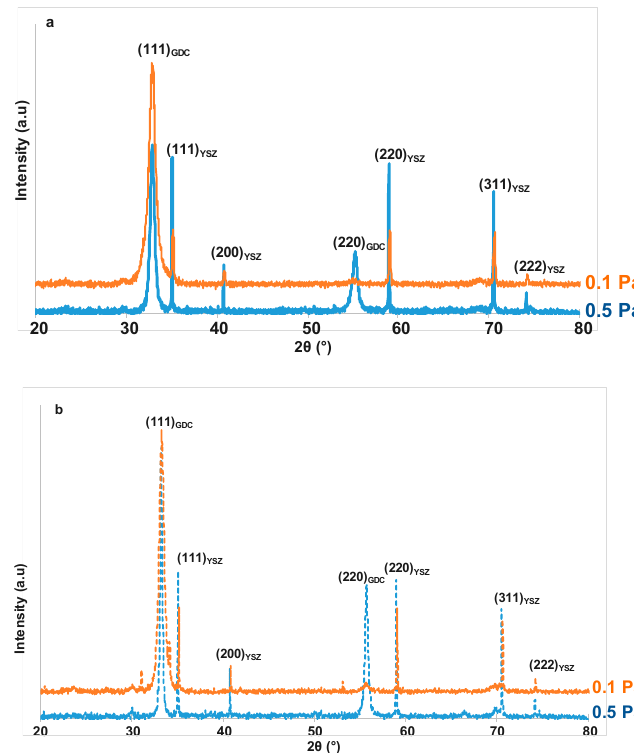
Figure 1. XRD patterns of gadolinia-doped ceria (GDC) coating as function of the total pressure ( a : as deposited, b : after annealing treatment under static air for two hours at 1000 °C).